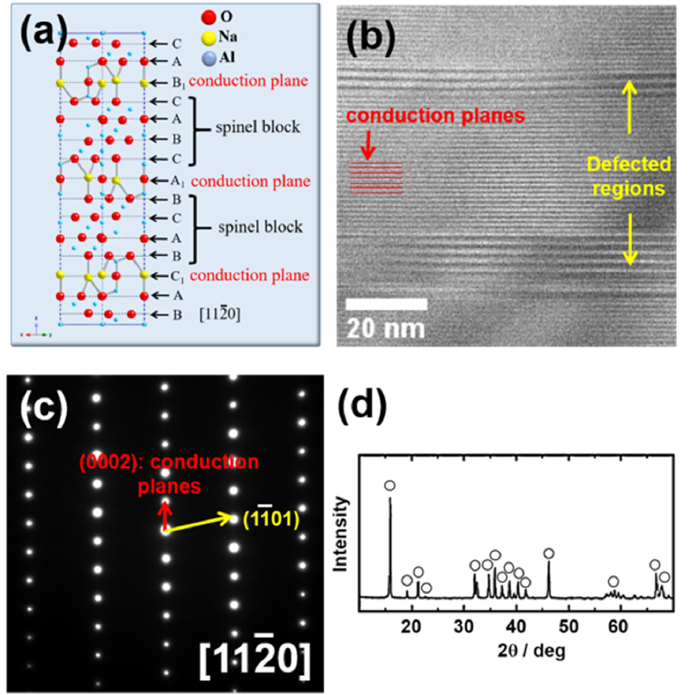
Figure 1. ( a ) Atomic structure of Na-β″-alumina viewed in the (cid:1)112(cid:4)0(cid:6) direction, ( b ) bright-field (BF) TEM micrograph showing the lattice of conduction planes with faulted regions, selected area diffraction pattern (SADP) with a zone axis of (cid:1)112(cid:4)0(cid:6) , ( c ) selected area diffraction pattern (SADP) with a zone axis of (cid:1)112(cid:4)0(cid:6) , ( d ) XRD pattern of the Na-β″-alumina powders.